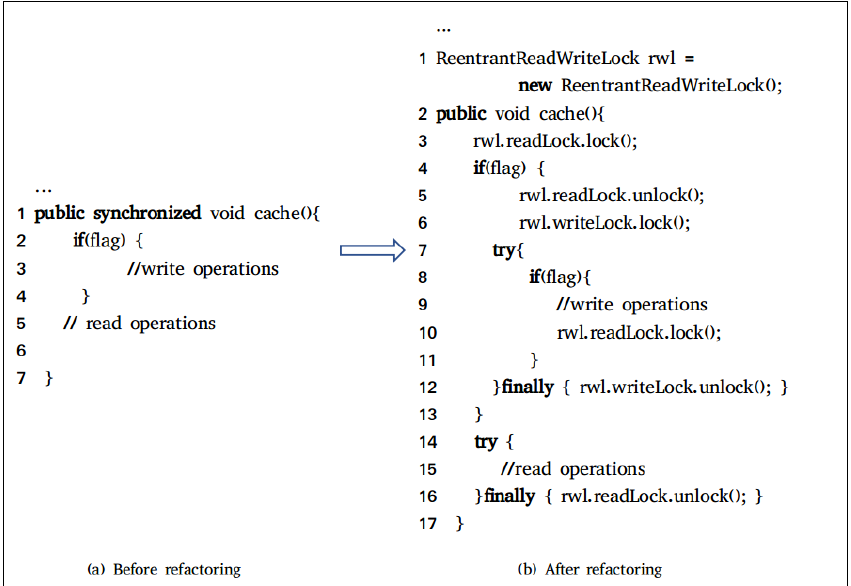
Figure 4. ( a ) Method cache() based on built-in monitors. ( b ) Method cache() using the lock downgrading of